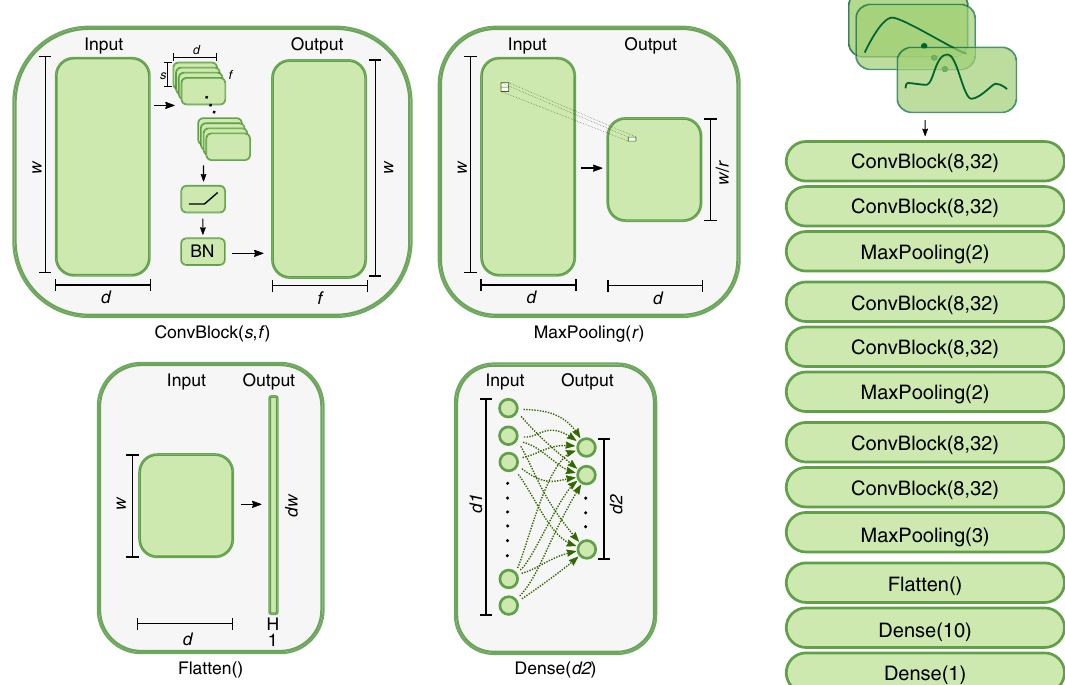
Fig. 6 Convolutional neural network architecture. Our CNN is composed of four types of blocks. The convolutional block (ConvBlock) maps a multivariate time series ( w × d ) into another multivariate time series ( w × f ) using f parameterized one-dimensional convolutions ( d × s ), i.e. sliding fi lters with learnable parameters. Convolutions are followed by a nonlinear activation function and a normalization component. The maximum pooling block (MaxPooling) extracts the maximum value from a sequence of r values, thus reducing the dimensionality from w to w/r . The fl attening block (Flatten) changes the shape of an array of dimensions w × d to a vector of dimensions dw . Dense block (dense) is a multiple linear regression from d1 dimensional space to d2 dimensional space with a nonlinear function at the output (see Methods). The diagram on the right shows the sequential combination of these blocks used in our fi nal